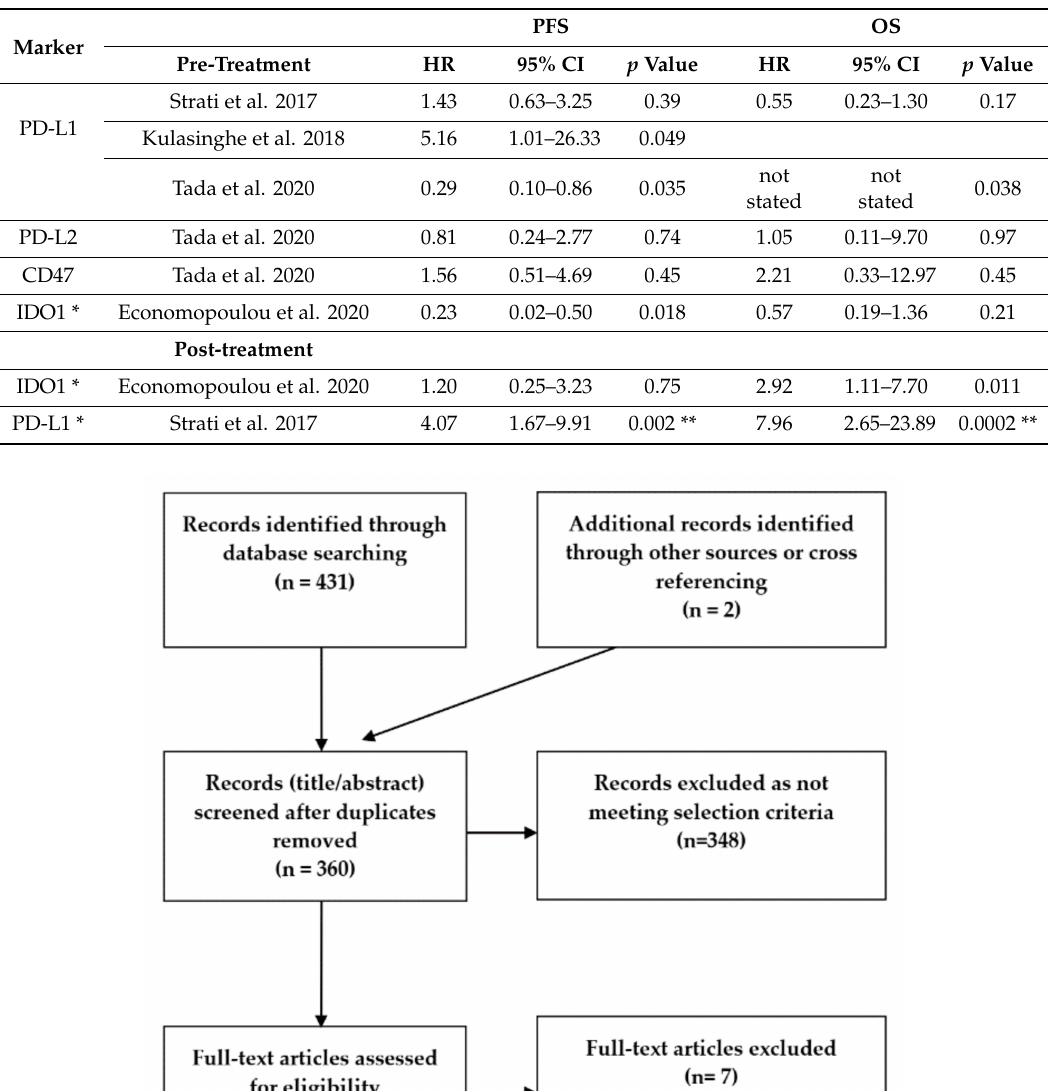
Table 2. Hazard ratio (HR), 95% confidence interval (CI) and p value log-rank data extracted from included studies for progression free survival (PFS) and overall survival (OS). (* = univariate cox regression, ** = author derived from presented data).